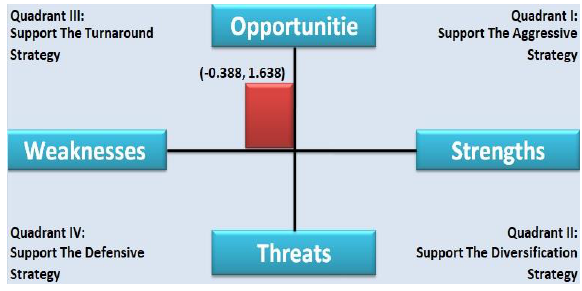
Figure 8: Position Company on The SWOT Diagram